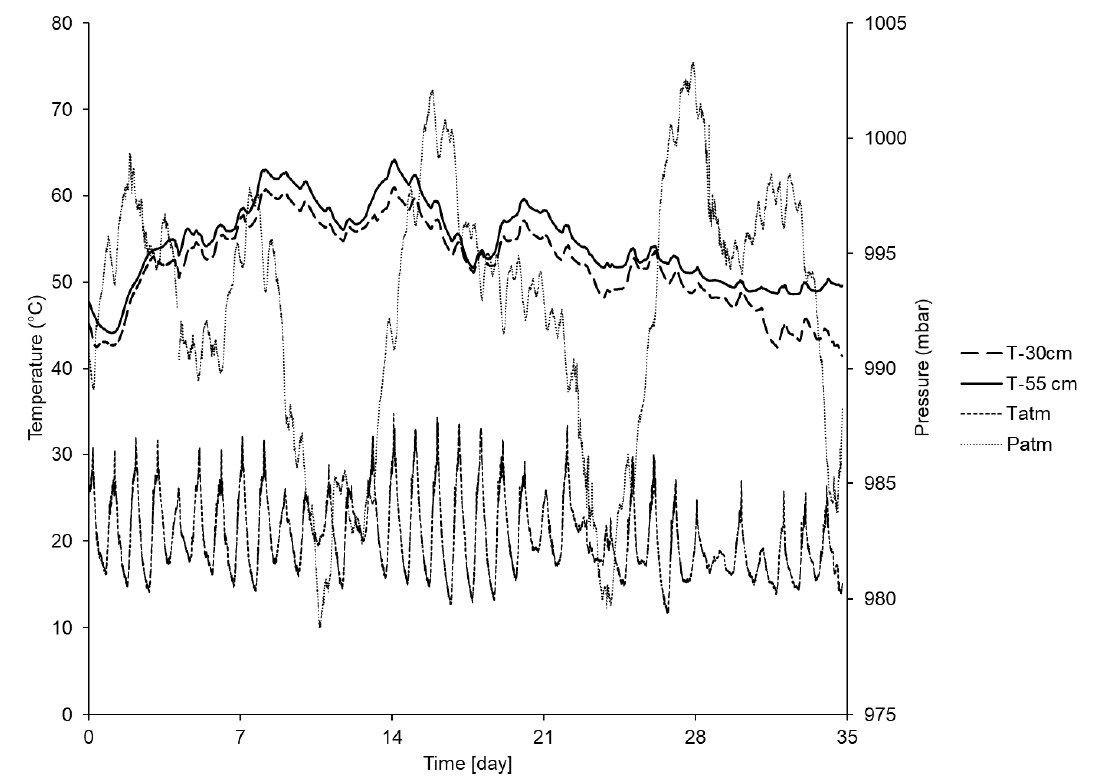
Figure 3. The temperature and environmental conditions evolution in Test 1.